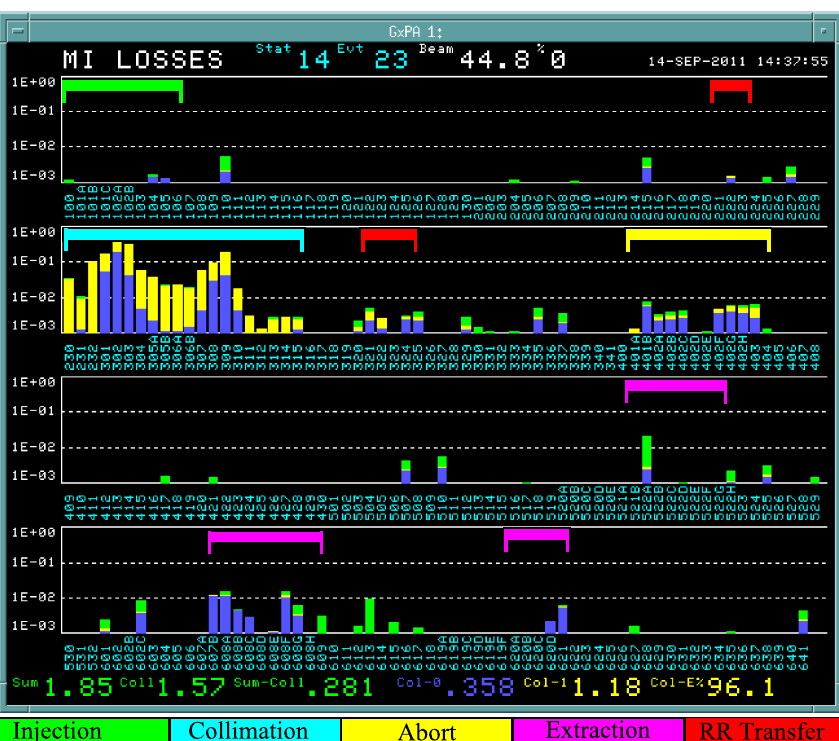
FIG. 3. Beam loss monitor display from Main Injector cycle in September 2011 at an intensity of 4 (cid:1) 10 13 protons prior to the end of pbar production. Loss monitors are shown sequentially around the Main Injector. Compare to Fig. 2 above. Some remaining BLM signals are due to pedestal offset, not beam